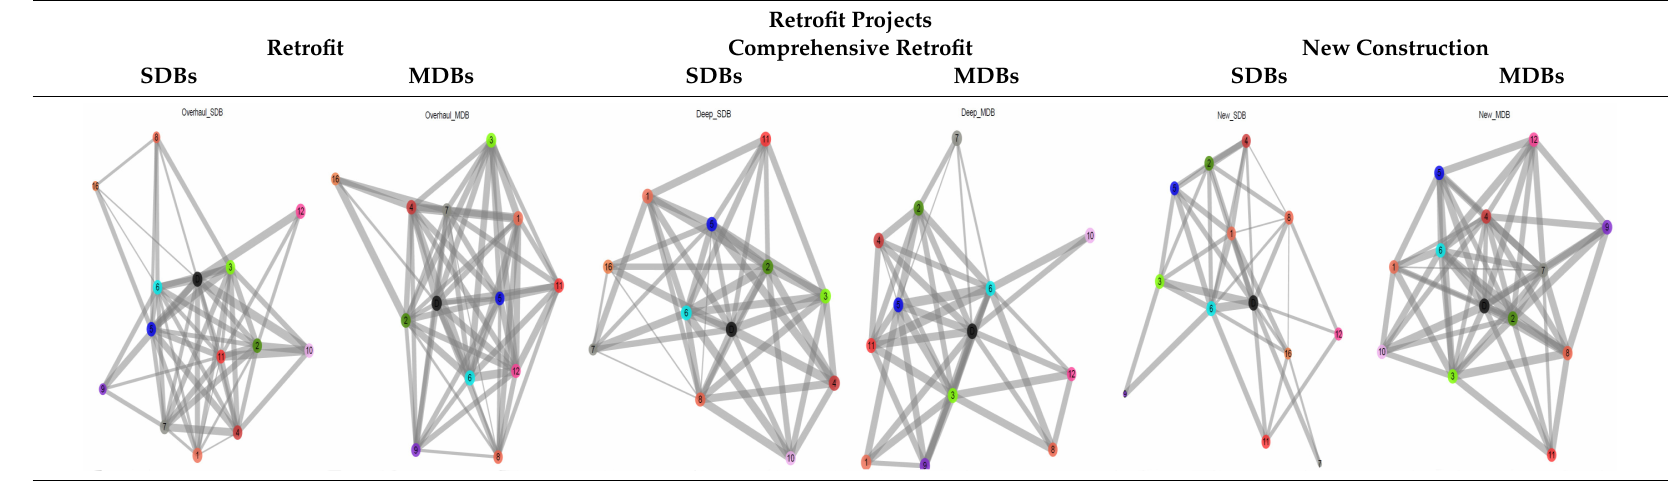
Table 10. Stakeholder level of power and interaction in the technology selection, classified according to building typologies and project types in the United Kingdom